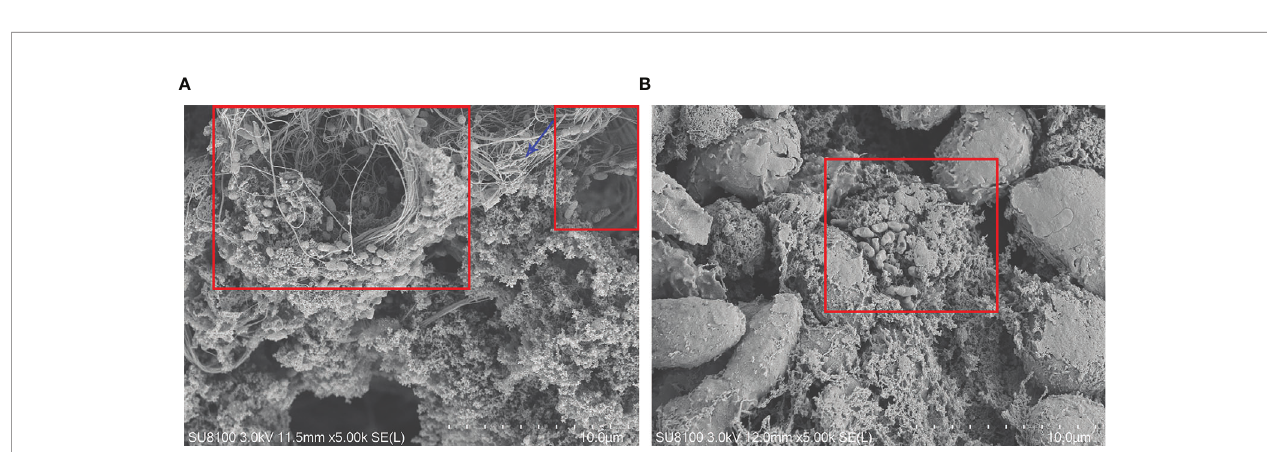
FIGURE 4 | Fibrin depositions and the synovial membrane surface by scanning electron microscopy 7 days after inoculation. (A) Bio fi lm structures on the synovial membrane surface (×5,000) ( B ). Bio fi lm structures in the fi brin depositions (×5,000). PAO1 wild-type strains were embedded in electron-dense extracellular matrix (red box), which appeared to be bio fi lm structures. The blue arrow indicates a fi brin